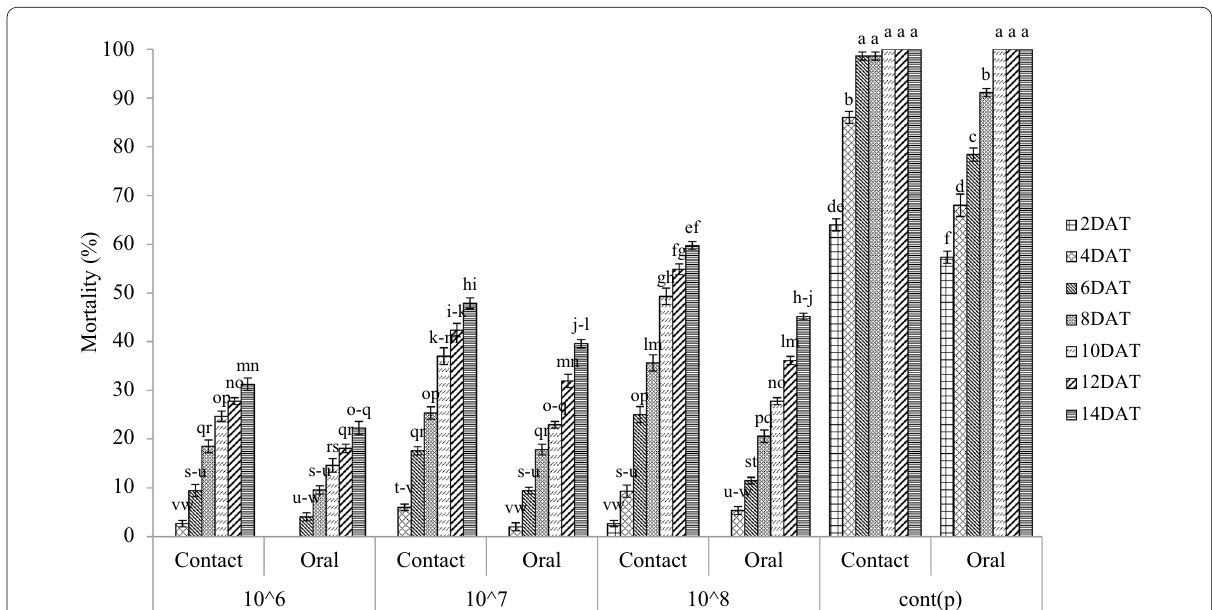
Fig. 4 Contact and oral pathogenicity of Metarhizium anisopliae against Bactrocera cucurbitae at three concentrations (10 6 , 10 7 and 10 8